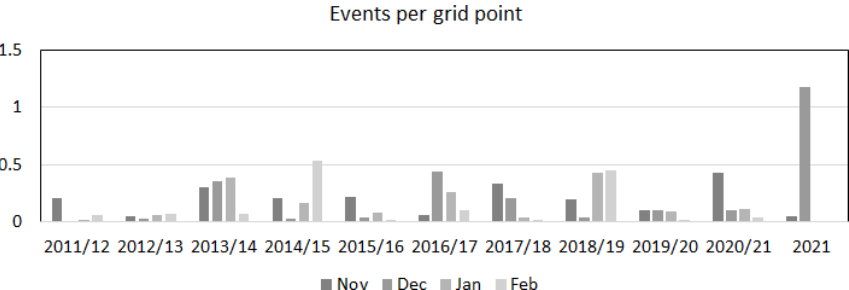
Figure 16. Example for monthly aggregated events. Number of events per grid point for the Seward Peninsula (for location see Fig. 15). SMOS masking (wet snow and RFI) has been